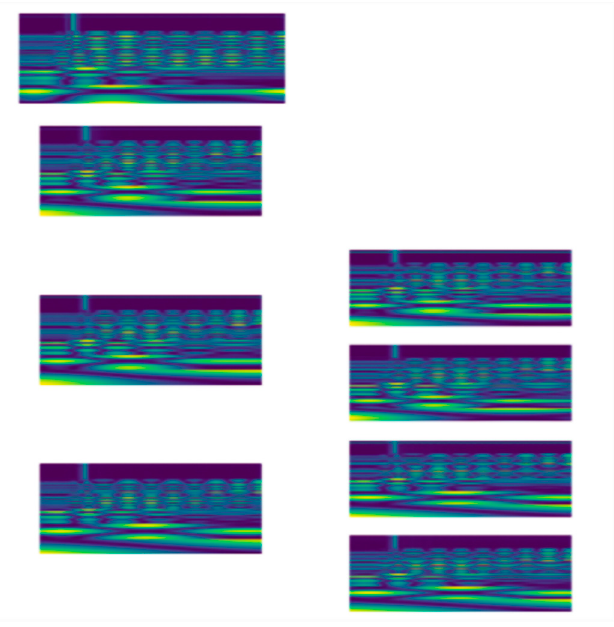
Figure 13. Distribution network Recurrence Plot.